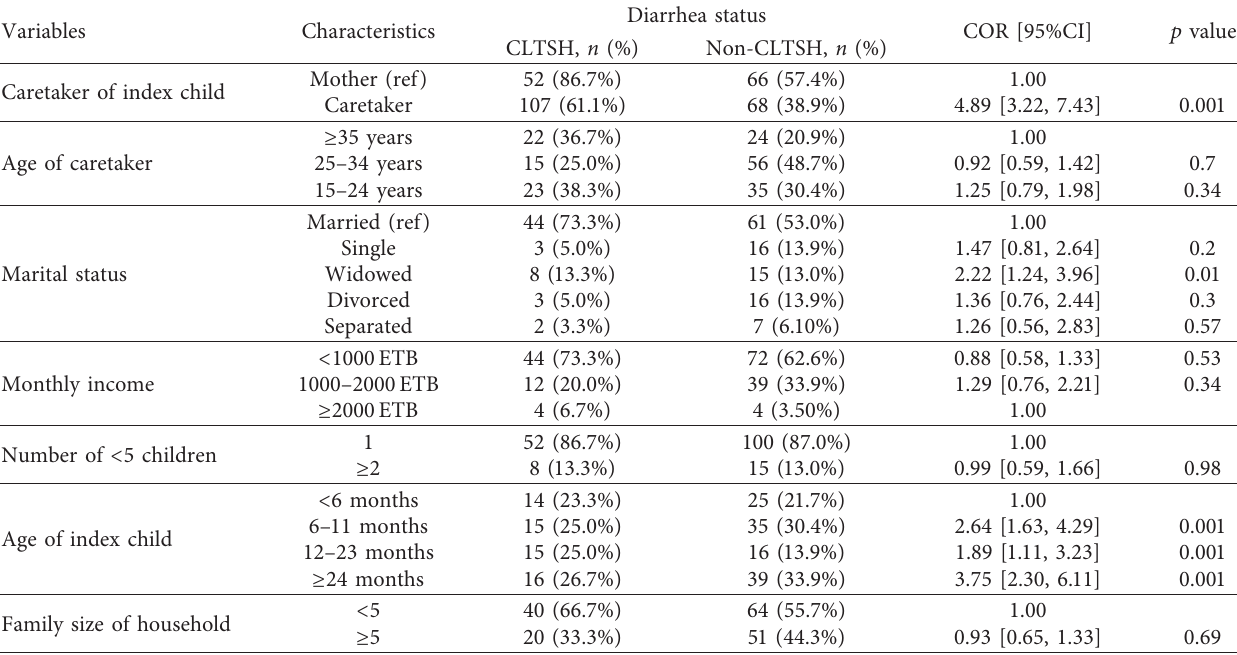
Figure 3: Bar chart shows the prevalence of diarrhea among under-five in CLTSH implemented and nonimplemented areas in Gamo Gofa Zone, 2018. Table 5: Bivariate analysis of sociodemographic variables related to diarrhea among under-five in selected CLTSH implemented and nonimplemented woredas in Gamo Gofa Zone, March